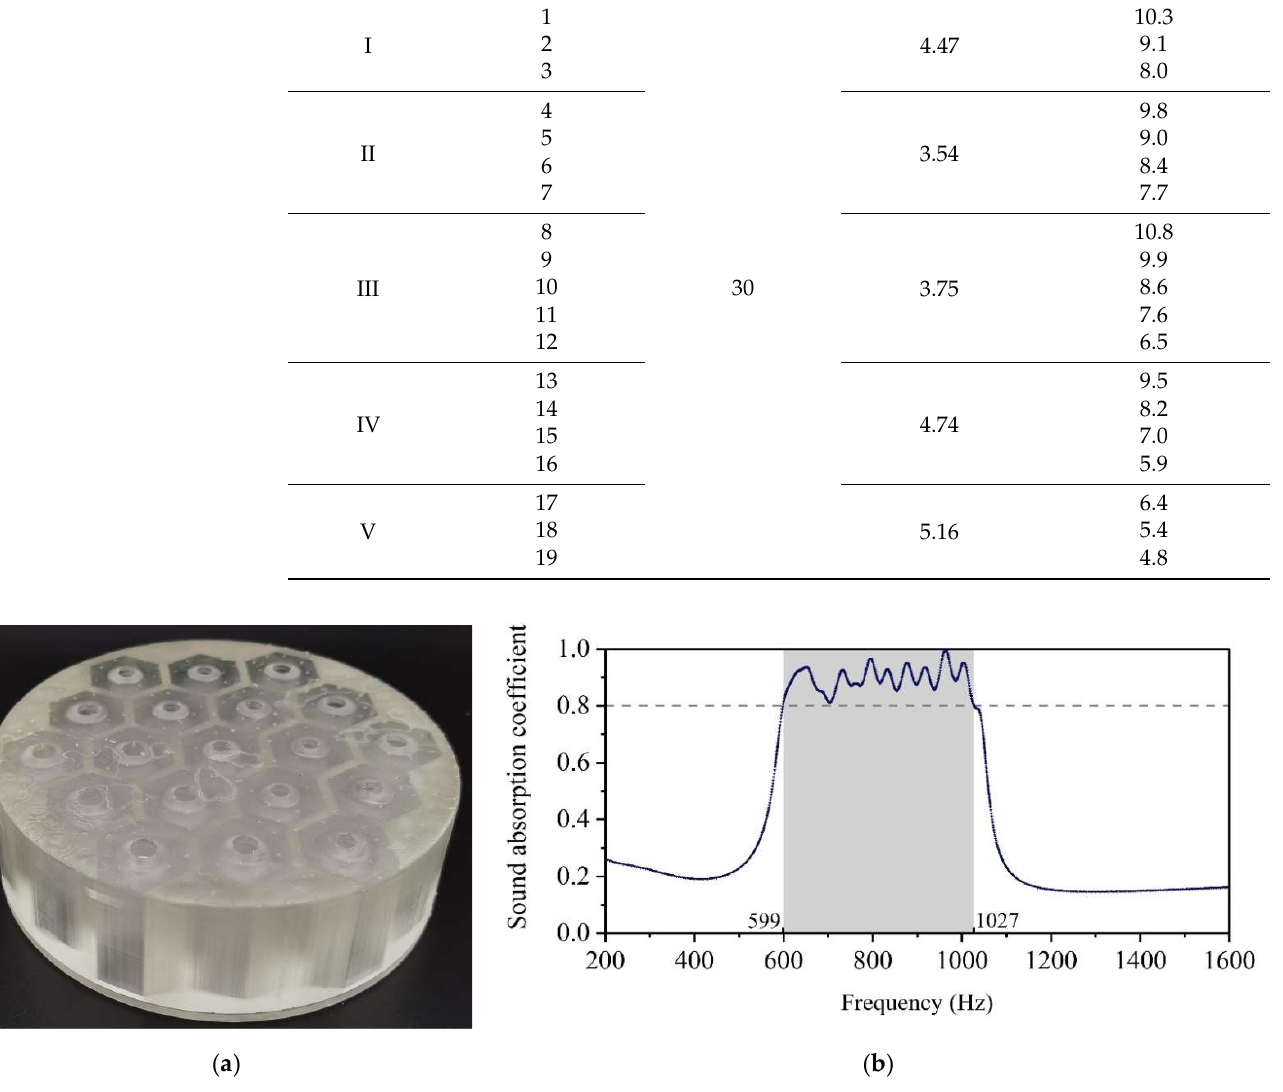
Table 4. The optimized geometric parameters for design requirements of Condition-2. Group